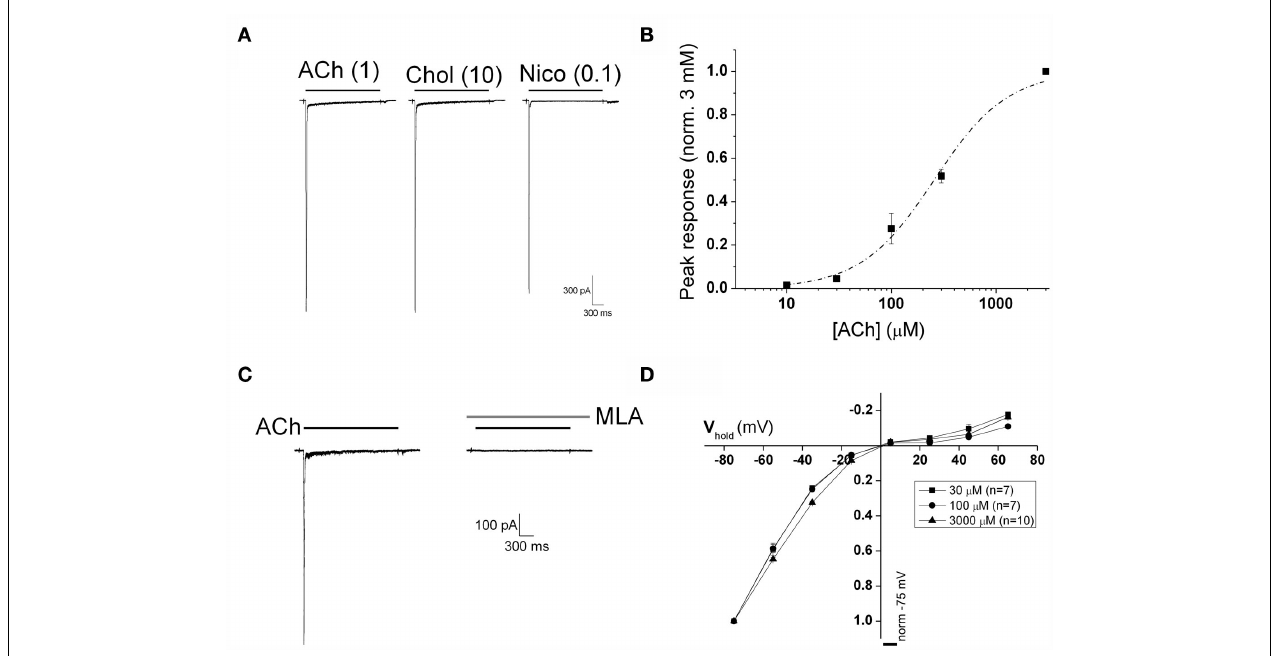
(EC 50 = 260 μ M; n = 7). (C) ACh-evoked currents (3mM) are completely abolished by pre-application of the selective α 7 nAChR blocker MLA (100nM). (D) Current–voltage relationships of currents evoked by three different ACh concentrations [30 μ M ( n = 7), 100 μ M ( n = 7), and 3mM, ( n = 10)]. Responses are normalized to the response recorded at a holding potential of − 75mV. Note the strong inward rectification at all agonist